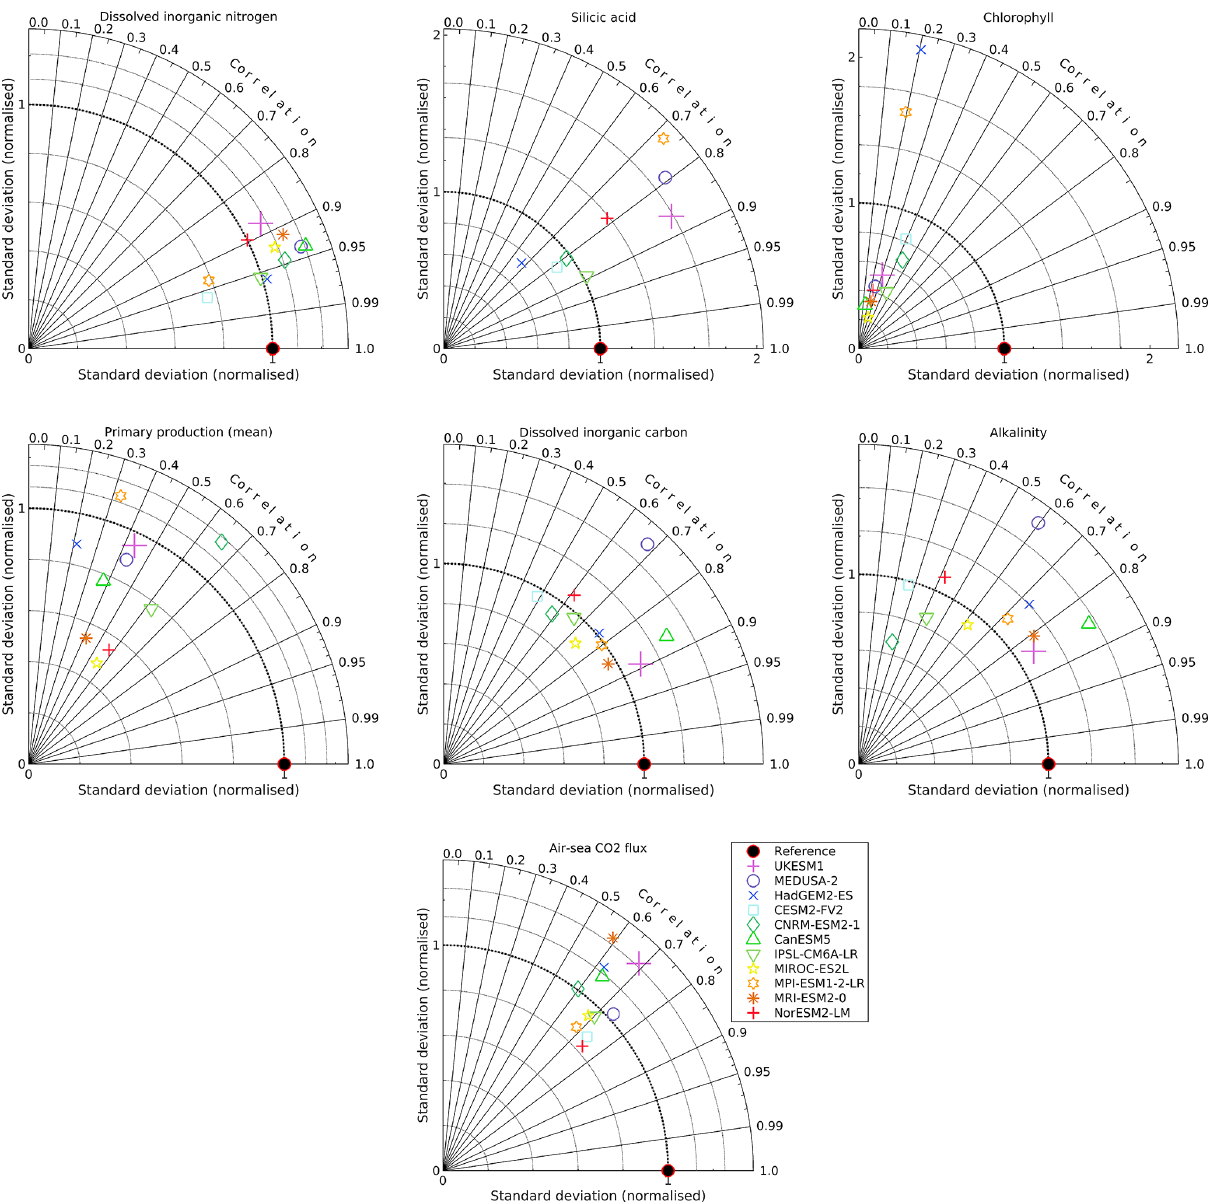
Figure 24. Taylor diagrams illustrating the skill of UKESM1 (and its precursors, HadGEM2-ES and MEDUSA-2) and a series of CMIP6 models over a set of standard surface ocean of biogeochemical properties: dissolved inorganic nitrogen (top left), silicic acid (top centre), chlorophyll (top right), primary production (middle left), dissolved inorganic carbon (middle centre), alkalinity (middle right) and air–sea CO 2 flux (bottom centre). The diagrams show model–observation comparisons based on annual average spatial fields, all regridded to the same standard grid. The diagrams share a common model key (bottom centre). Black symbols denote skill scores that lie outside of the plot